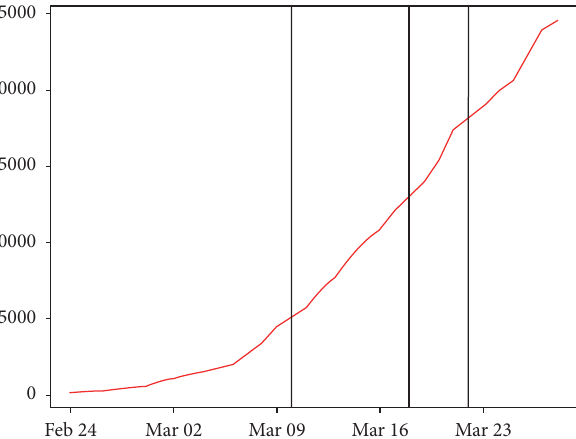
Figure 2: Number of people tested positive (Lombardia) (data adjusted via Kalman